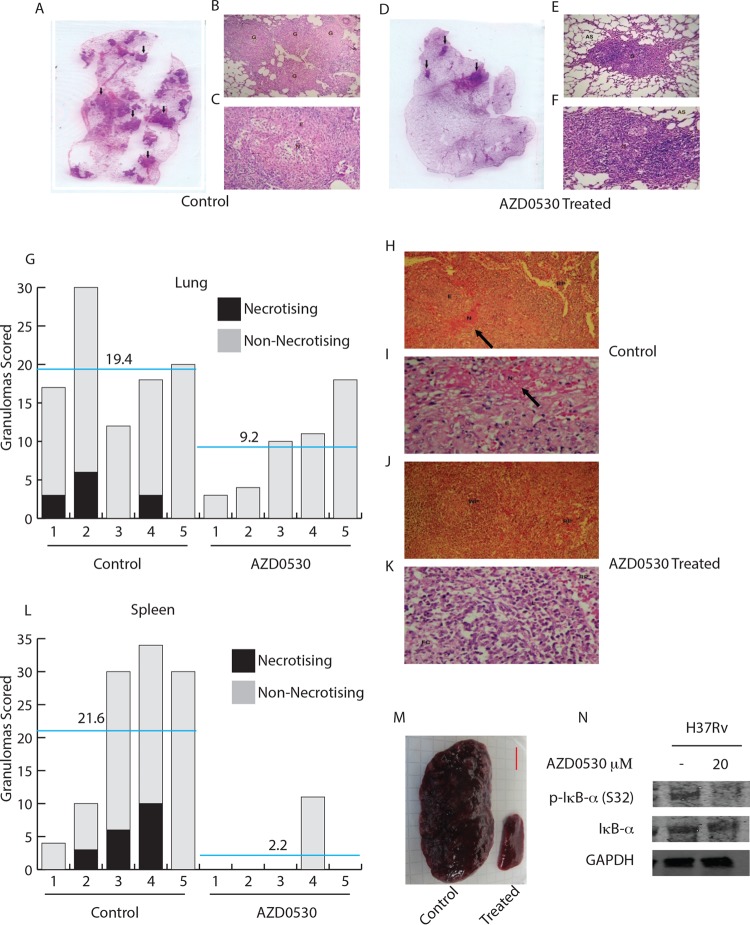
Reduced pathological damage in lungs and spleens of guinea pigs infected with H37Rv upon AZD0530 treatment. After 8 weeks of treatment, the lung and spleen tissues of the test animals were harvested and subjected to histopathological analyses. (A) Lung tissue from an untreated animal with granulomatous lesions (black arrows) is shown here. (B) Low-power photomicrograph (×40) of this lung tissue shows multiple granulomas in the lung parenchyma. (C) High-power photomicrograph (×100) showing the cellular composition in one of the granulomas. A central zone of necrosis surrounded by epithelioid cells can be observed. (D) The lung tissue from a treated animal showing lesser granulomatous lesions (black arrows). (E and F) No necrotic zones were observed in the granulomas at ×40 (E) and ×100 (F) magnifications. (G) Plot representing number of granulomas (necrotizing and nonnecrotizing) counted in lung sections from treated and untreated animals. The blue lines represent the average value for the untreated or treated sets of animals. (H) A section of spleen from an untreated animal at ×100 magnification is shown here. A large granuloma with central necrosis in the white pulp of the spleen can be observed (N). (I) High-power photomicrograph (×400) from the granuloma shows necrosis (N) in the upper half of the image with epithelioid cells in the lower half. (J) Spleens from the treated animals had no granulomatous lesions. A section of spleen from a treated animal showing normal splenic parenchyma is presented here at ×100 magnification. (K) High-power photomicrograph (×400) of the same section shows a portion of a lymphoid follicle in the white pulp. (L) Plot representing number of granulomas (necrotizing and nonnecrotizing) counted in the spleen sections from treated and untreated animals. The blue lines represent the average values for the untreated or treated sets of animals. (M) Splenomegaly was observed in infected guinea pigs that did not receive AZD0530 treatment (bar, 1 cm). G, granuloma; N, necrosis; E, epithelioid cells; AS, alveolar space; RP, red pulp; WP, white pulp; FC, follicular center. The images depicted here are stained with hematoxylin and eosin. (N) Phosphorylation of IκBα in H37Rv-infected THP-1 macrophages that were either untreated or treated with AZD0530 (20 µM) at 48 h postinfection.